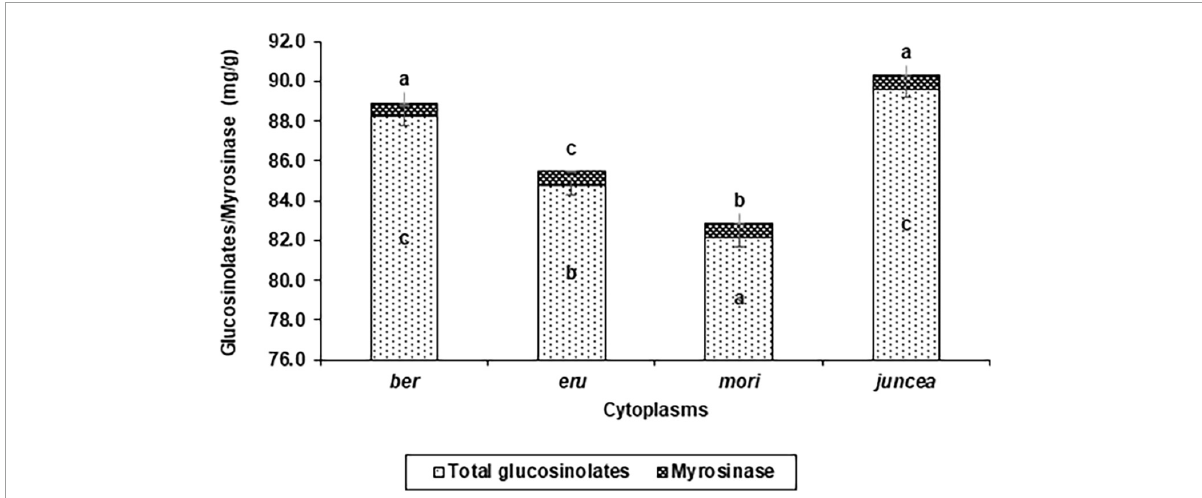
FIGURE4 Effects of cytoplasms on total glucosinolate and myrosinase contents in Brassica